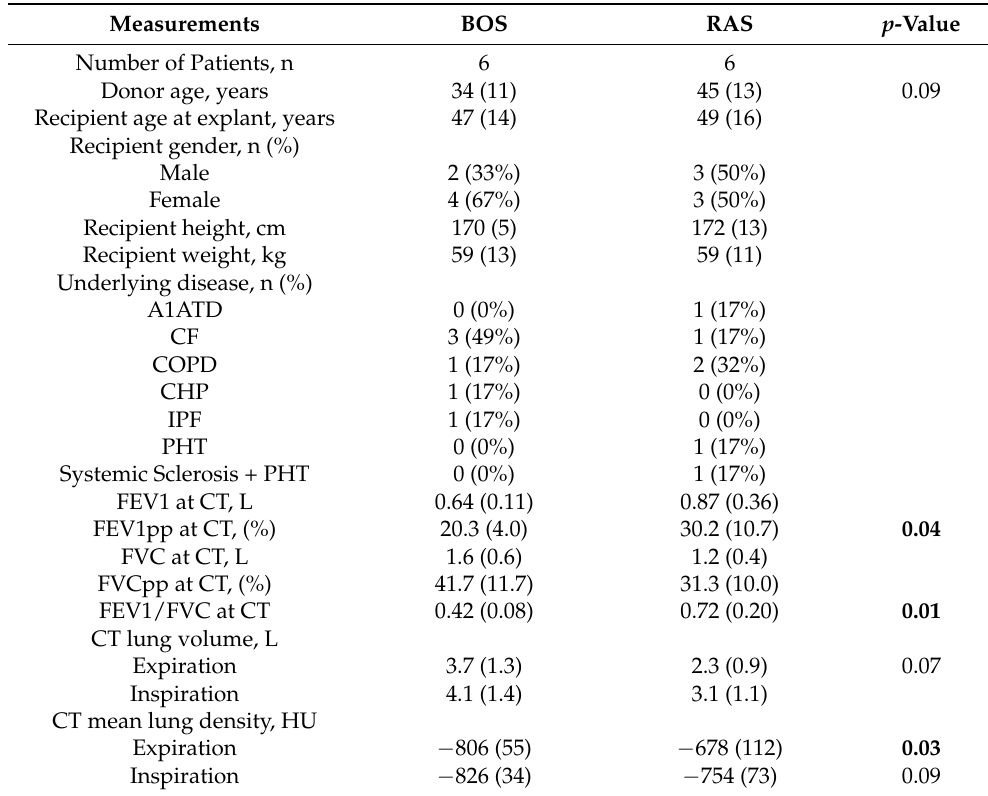
Table 1. Subject